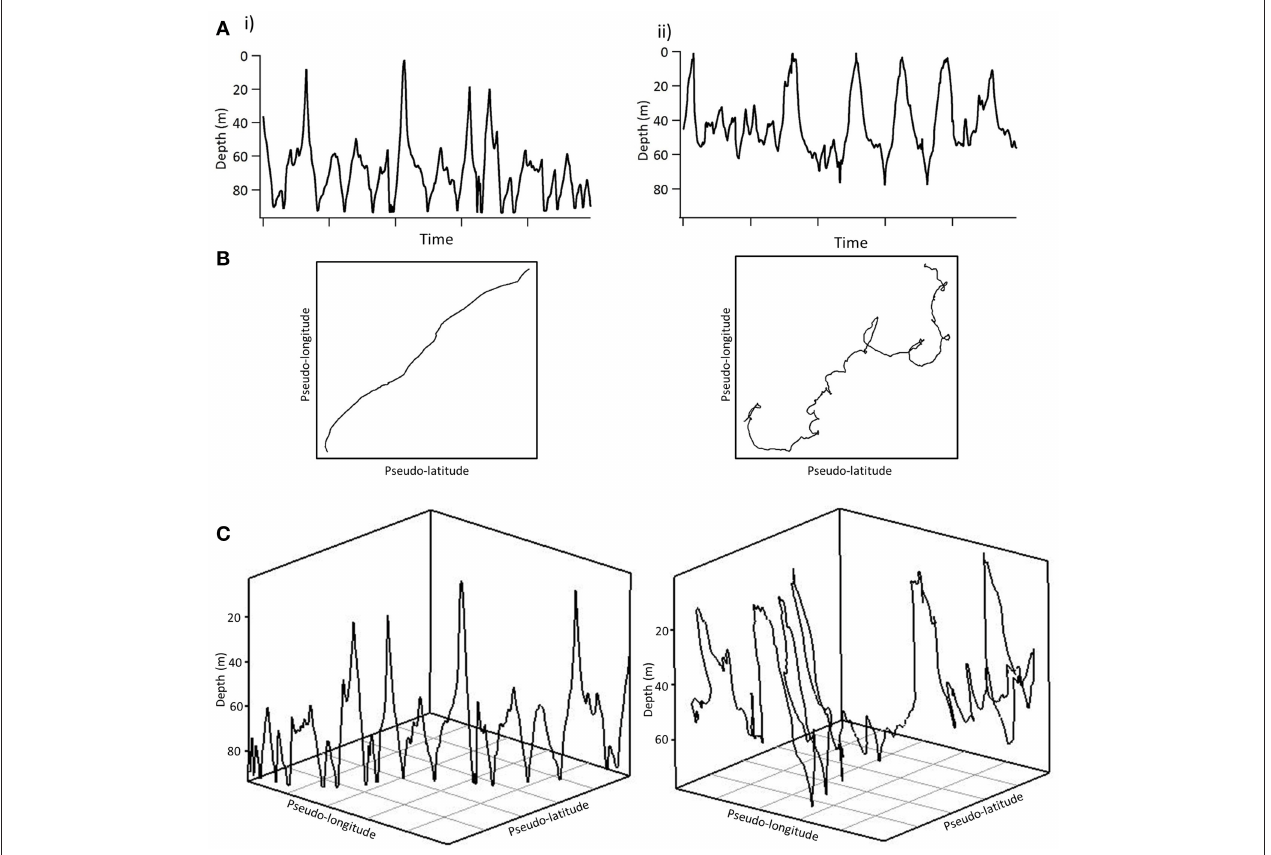
FIGURE 6 | Two tiger sharks (i and ii) with very similar oscillatory depth tracks but different horizontal tracks in offshore environments over a 2.5h period. (A) Depth track. (B) Pseudo-track. (C) 3D track. Each pseudo-plot and 3D track is displayed in approximately the same amount of horizontal area. As constant speed was used to estimate pseudo-tracks, we caution that speed changes by tagged sharks may slightly influence the shape of resulting pseudo-tracks.